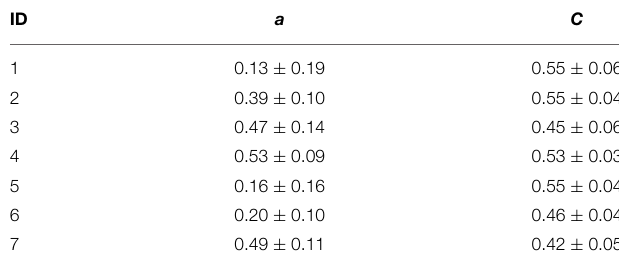
green) denote the mean assortativity coefficient of Erd˝os-Rényi networks having the same number of nodes and the same link density as the functional networks. Below the time courses, we show the respective frequency distributions of the assortativity coefficient and power spectral density estimates of the temporal evolutions (Lomb-Scargle periodograms, computed by applying the algorithm proposed in Press and Rybicki, 1989 to the full, unfiltered, demeaned time